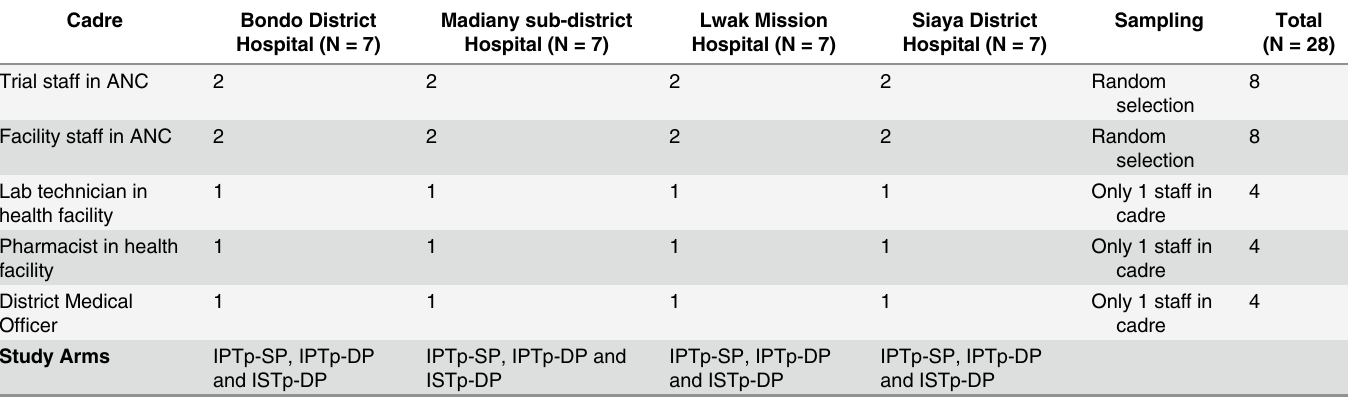
Table 2. Selection of trial staff and health providers for the in-depth interviews.